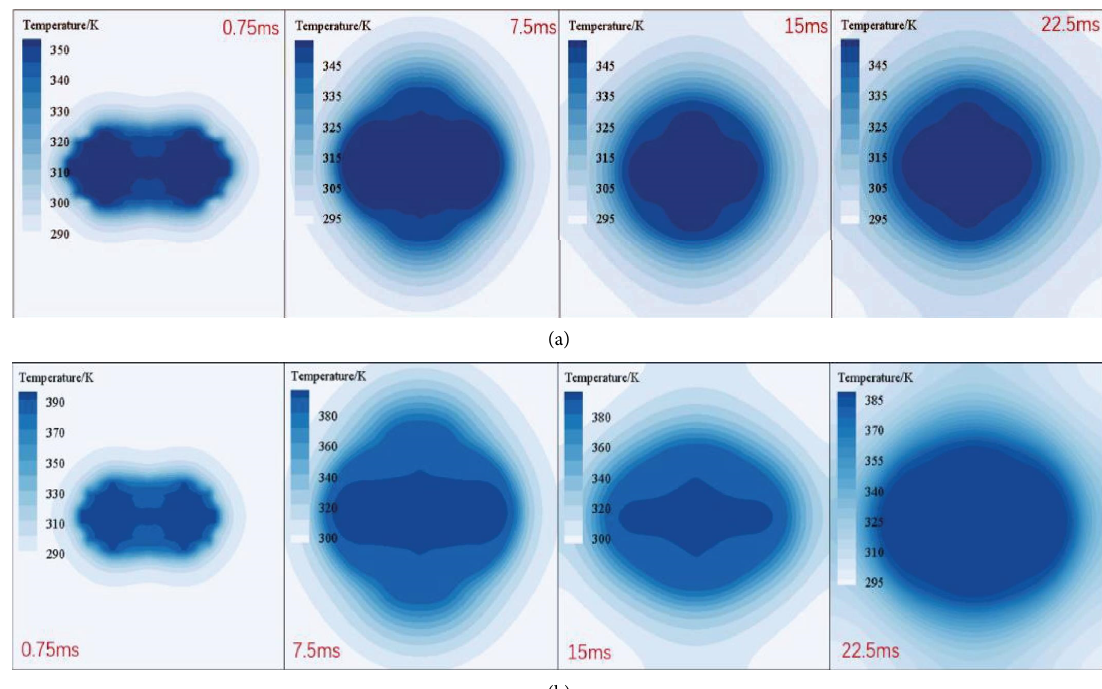
Figure 7: Temperature change during a collision at diferent initial temperatures of the droplets. (a) 353K and (b)